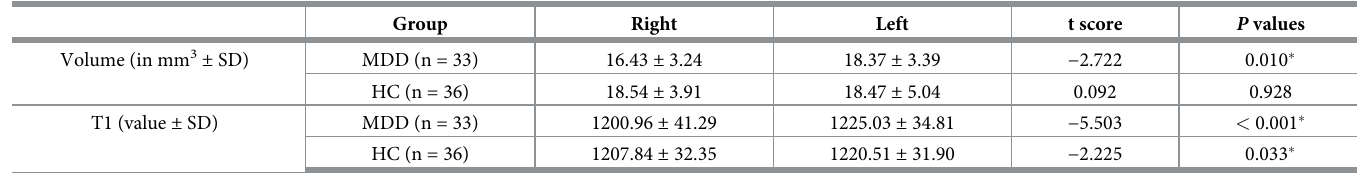
Hb volume and T1 values were calculated from overlapping voxels in the right and left Hb regions across all subjects. The mean overlapping volumes in each Hb are 15.63 to 19.98 as shown in Tables 2 and 3, Fig 3 , respectively. The ICC coefficients were 0.703 ( P < 0.001) and 0.656 ( P < 0.001) in the right and left Hb, respectively. The average overlap index ratio of the quantitative analysis by the two examiners are as follows: the overlap index ratio (mean ± standard deviation [SD]) of the two examiners was 71.85 ± 7.47 in the right Hb and 73.76 ± 7.96 in the left Hb (MDD group; n = 33) and 70.90 ± 8.22 in the right Hb and 69.92 ± 6.87 in the left Hb (HC group; n = 36). In Fig 3 , the volume and T1 values of the right and left Hb in each group are visualized as scatter plots including the mean and SD. In the between group comparison, according to the results of the ANCOVA, which included age, sex, and education level as covariates, there was a significant difference in the right Hb volume ratio between the MDD and HC groups (F = 5.544, p = 0.022, Table 2 ). The partial eta-squared values (representing the effect size) for the left and right Hb volume ratios were small ( η 2 = 0.001) and relatively large ( η 2 = 0.080), respectively. In the analysis using Stu- dent’s t-test, participants with MDD had a significantly smaller right Hb volume than those in the HC group ( P = 0.018, S1 Table ). There was no significant difference in the left Hb volume between the two groups. This is consistent with the results from the ANCOVA, in which the volume of the right Hb differed significantly between the two groups. The inter-hemispheric difference in Hb volume and T1 value between the left and right Hbs was compared in each group. There was a significant difference in the Hb volume and T1 value between the left and right Hbs only in the MDD group ( P = 0.010 in volume and P < 0.001 in T1 value, Table 3 ). In the HC group, there was a significant difference in T1 value between the left and right Hbs ( P = 0.033); however, there was no significant inter-hemispheric volume difference ( P = 0.928, Table 3 ).